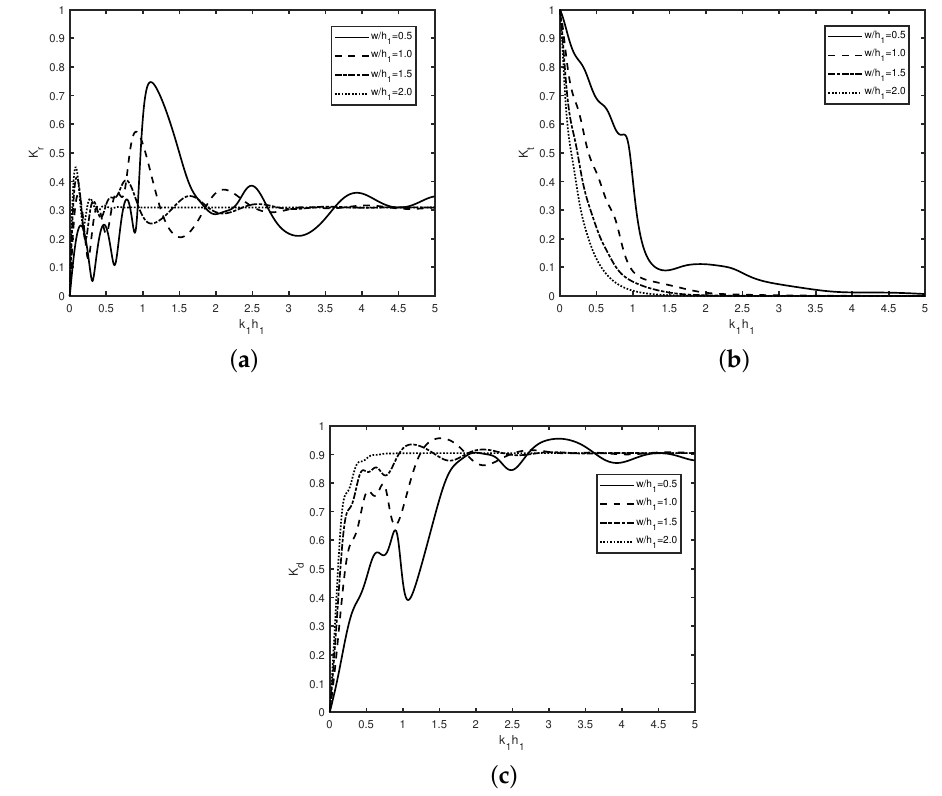
Figure 6. Variation of ( a ) reflection coefficient K r , and ( b ) transmission coefficient K t , ( c ) dissi- pation coefficient K d versus wavenumber k 1 h 1 for different w / h 1 with C f = 0.5, h 2 / h 1 = 0.25, d / h 1 = 2, θ = 20 ◦ , N = 4, h 1 = 5